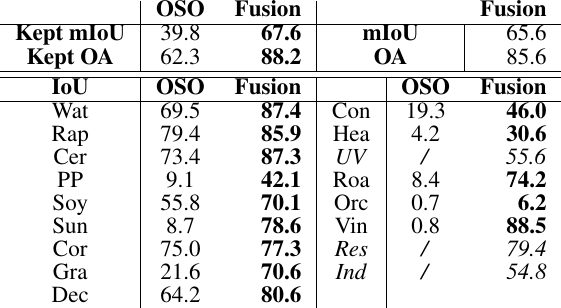
Table 5. Results (in %) for OSO classification and its reclassified version. Kept mIoU and Kept OA omitted incomparable